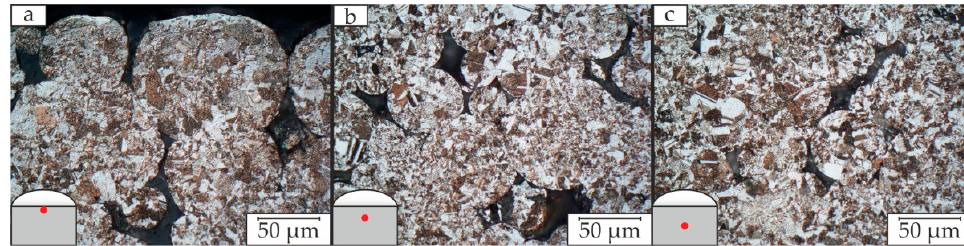
Figure 5. Microstructure in defined positions a, b and c according to Figure 1 (right) of a GE48 sample sintered at 1150 °C, with 2 min dwell time and 30 MPa pressure.